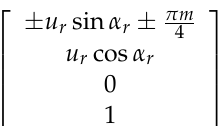
Figure 11. The tooth surface generating process of curve face gear pair.